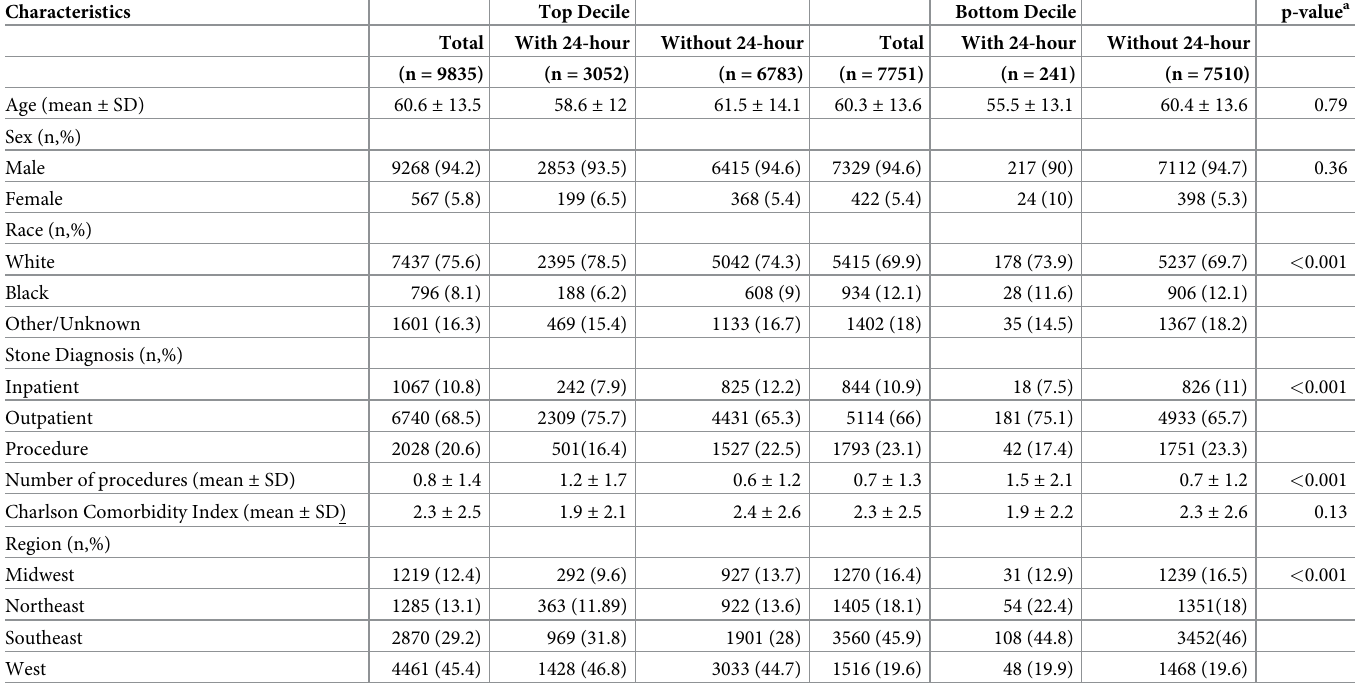
Table 5. Baseline characteristics of stone formers with and without a 24-hour urine collection in the top and bottom decile of VHA facilities that administer 24-hour urine testing.